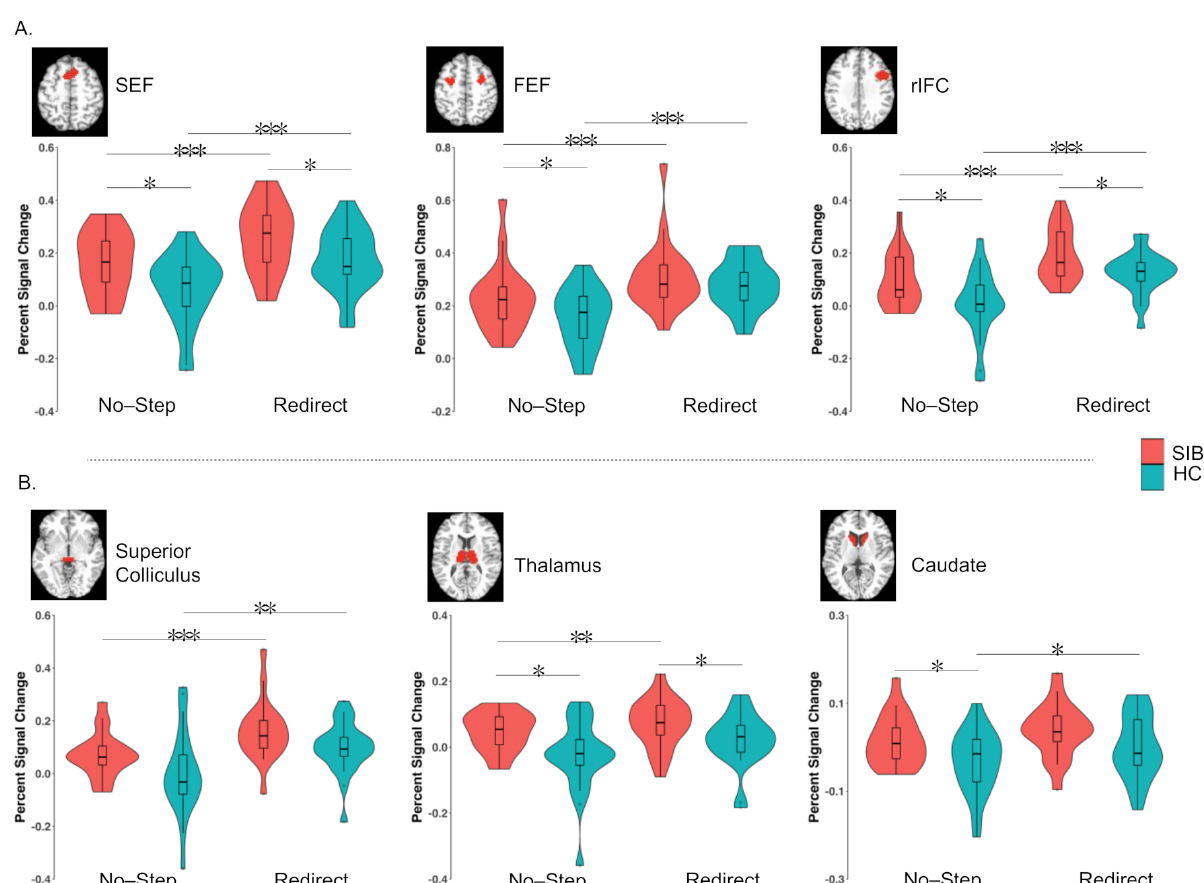
Figure 5. Violin plots of percent signal change for the redirect and no-step trials in ( A ) cortical and ( B ) sub-cortical regions of interest for the SIB and HC groups. Boxplots depict the median and quartile values. Outliers with values beyond two interquartile intervals from the median appear as individual dots. Visualized significant differences reflect paired t -tests for within group comparisons and independent t-tests for between-group comparisons (* p < 0.05, ** p < 0.01, *** p < 0.001). SEF: supplementary eye fields (bilateral); FEF: frontal eye fields (bilateral); rIFC: right interior frontal